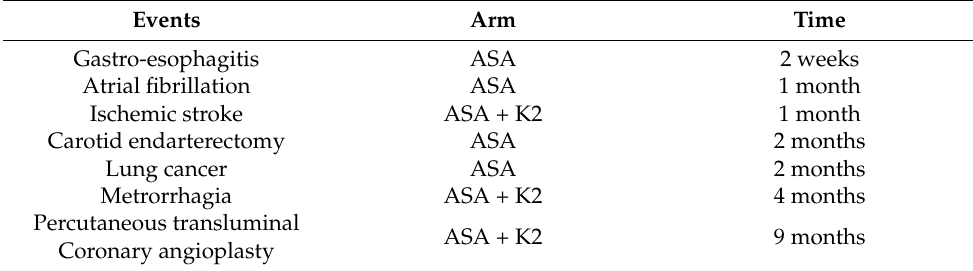
Table 1. Adverse events recorded during the